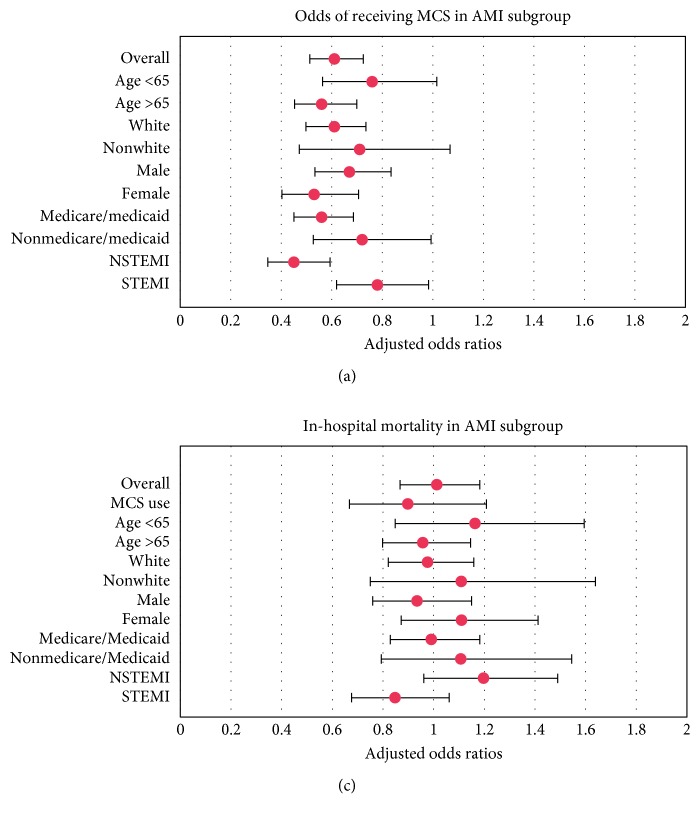
Use of mechanical circulatory support and in-hospital mortality in the subgroup of patients with acute myocardial infarction and cardiogenic shock in reporting states. ∗AMI: acute myocardial infarction; MCS: mechanical circulatory support; NSTEMI: non-ST-segment elevation myocardial infarction; STEMI: ST-segment elevation myocardial infarction.